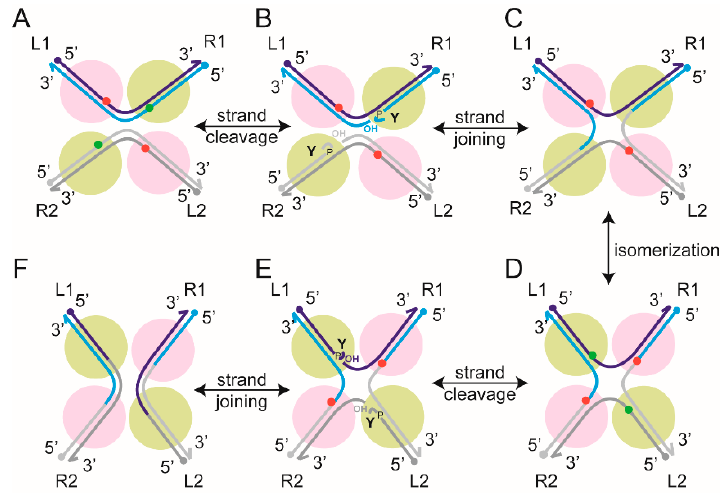
Figure 3. Tyrosine site-specific recombination. ( A ) Within the core recombination synapse, the partner sites (L1-R1 and L2-R2), each bound by two recombinase monomers, are arranged in an anti-parallel geometry. The bound sites have a considerably larger bend than that seen in the sites bound and synapsed by serine recombinases (see Figure 2). The scissile phosphates on the two strands are spaced farther apart (6–8 bp) than in the target sites of serine recombinases. The two scissile phosphates poised for cleavage are shown in green, with the other two in red. The two recombinase monomers responsible for the activation of the phosphates (active monomers) are shown in pale green. The ‘inactive’ ones are shown in magenta. The figure does not include accessory proteins and their interaction with cognate DNA sites required for the activity of a subset of tyrosine recombinases. ( B ) Single-strand cleavage within each partner results in the covalent linkage of the active site tyrosine to the 3 ′ -phopshate, leaving an adjacent 5 ′ -hydroxyl group as its neighbor. ( C ) Strand joining across partners by reversal of the cleavage chemistry produces a Holliday junction intermediate. ( D ) A conformational redisposition of the DNA arms within the synapse (isomerization) activates the scissile phosphates on the strands to be exchanged. The switch between the ‘active’ and ‘inactive’ Flp monomers is indicated by their change in colors (from magenta to pale green, and vice versa). ( E ) As depicted in ( B ), strand cleavage, covalent DNA–protein attachment, and exposure of the 5 ′ -hydroxyl group follow. ( F ) Strand joining completes the duplex exchange to give L1-R2 and L2-R1 as recombinant products. One of the tyrosine recombinases (Cre) that we studied using TPM follows the ( A – F ) path strictly, while the other (Flp) differs slightly in the mechanism of strand cleavage. In both cases, a scissile phosphate is activated by the adjacent recombinase monomer (pale green). In Cre, the tyrosine nucleophile for strand cleavage is also provided by the same monomer (in cis); in Flp, it is delivered by a neighboring monomer (magenta; in trans).